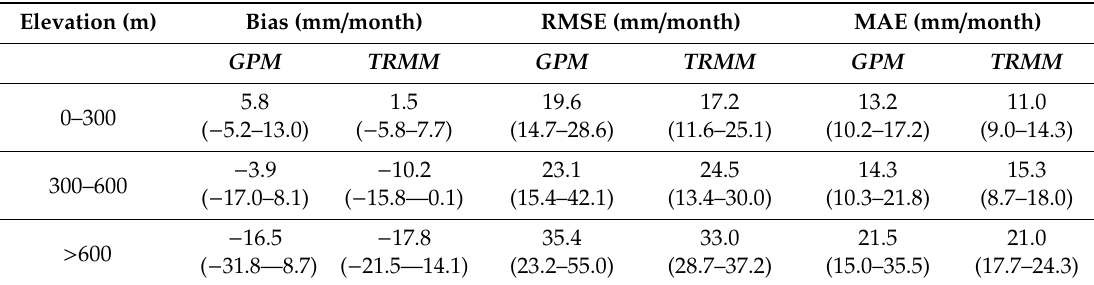
Table 7. Metrics (Bias, RMSE, MAE) performance for GMP and TRMM monthly data according to elevation (the range of values is given in